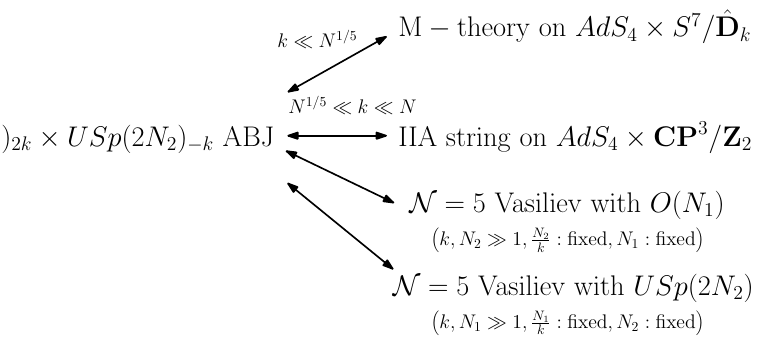
Figure 3 . Summary of our proposal on the ABJ quadrality among the string/M-theory and two group, namely N = min(rank( O ( N 1 )) , N 2 ). The main difference from the have two higher spin limits corresponding to the